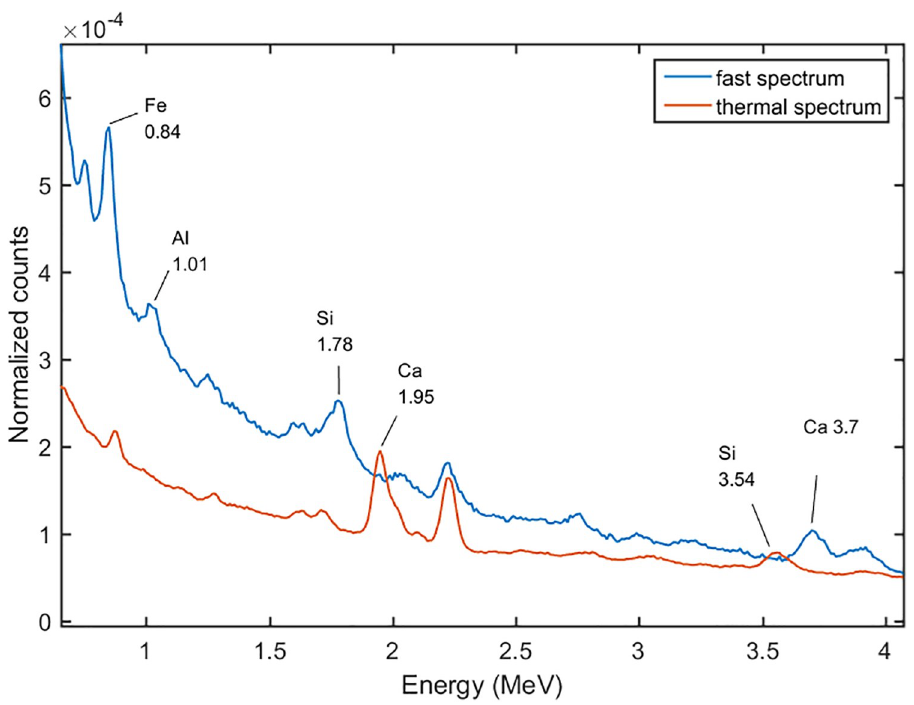
Fig 7. The gamma-ray spectra at different time intervals at the energy range of 0 to 4 MeV.